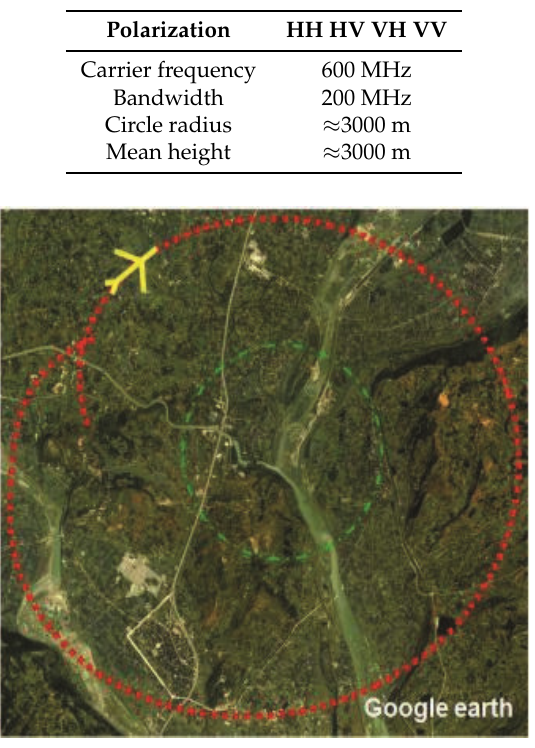
Figure 1. Experimental settings. Red line: aircraft trajectory; green line: area with 360 ◦ illumination